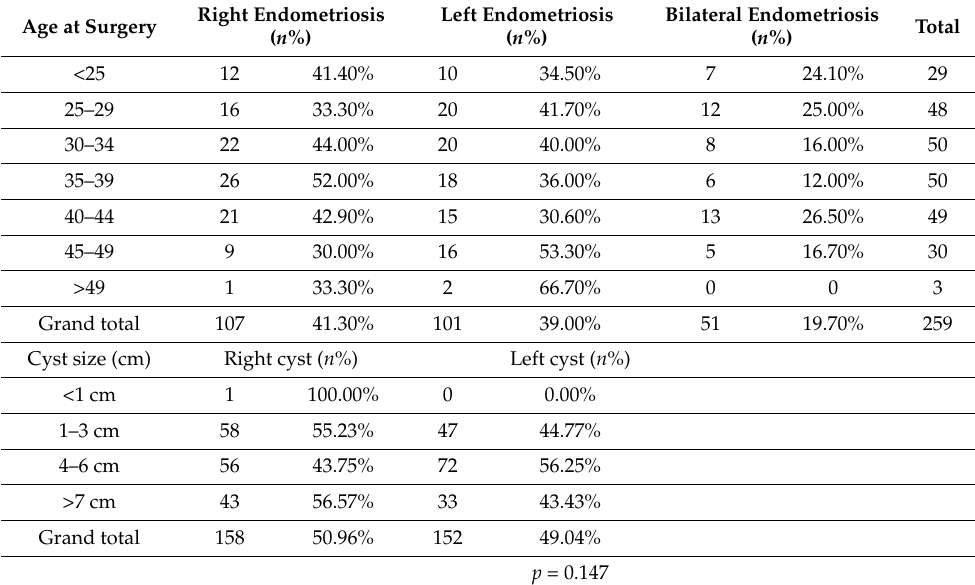
Table 1. Localization and size of the endometriotic